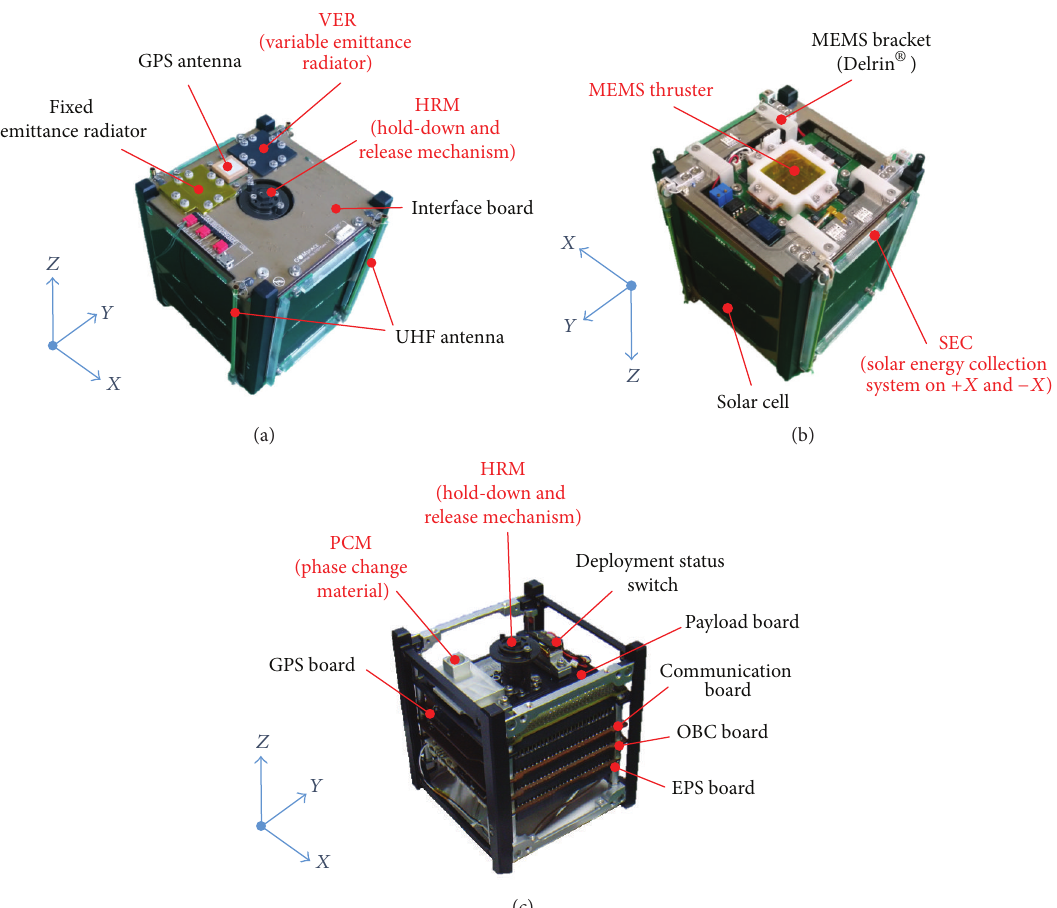
Figure 1: Mechanical configuration of the STEP Cube Lab ((a) and (b) external configuration, (c) internal configuration).